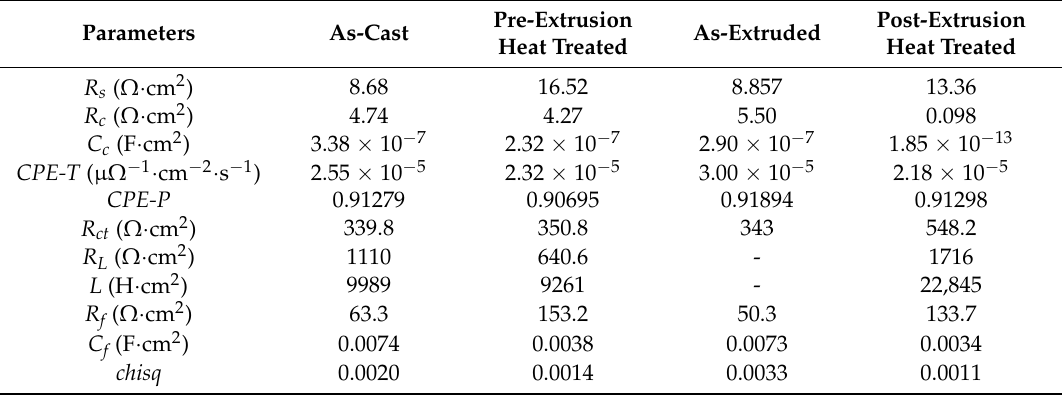
Table 2. The fitted parameters of the equivalent circuit model by the Nyquist plots.